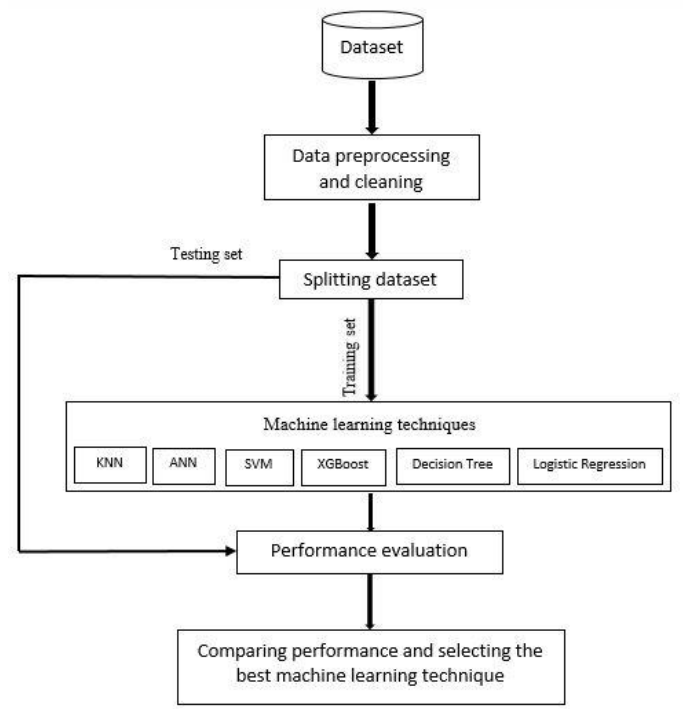
Figure 1. Proposed framework for hepatitis C prediction.